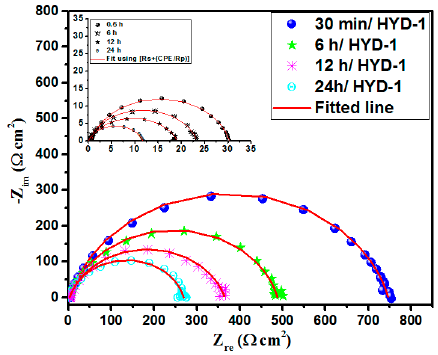
Figure 8. Nyquist curves of mild steel in 1.0 M HCl solution without and with 5 × 10 –3 M of HYD-1 at various times. Table 5. EIS parameters for mild steel in the absence and presence of HYD-1 at various times. Inhibitor